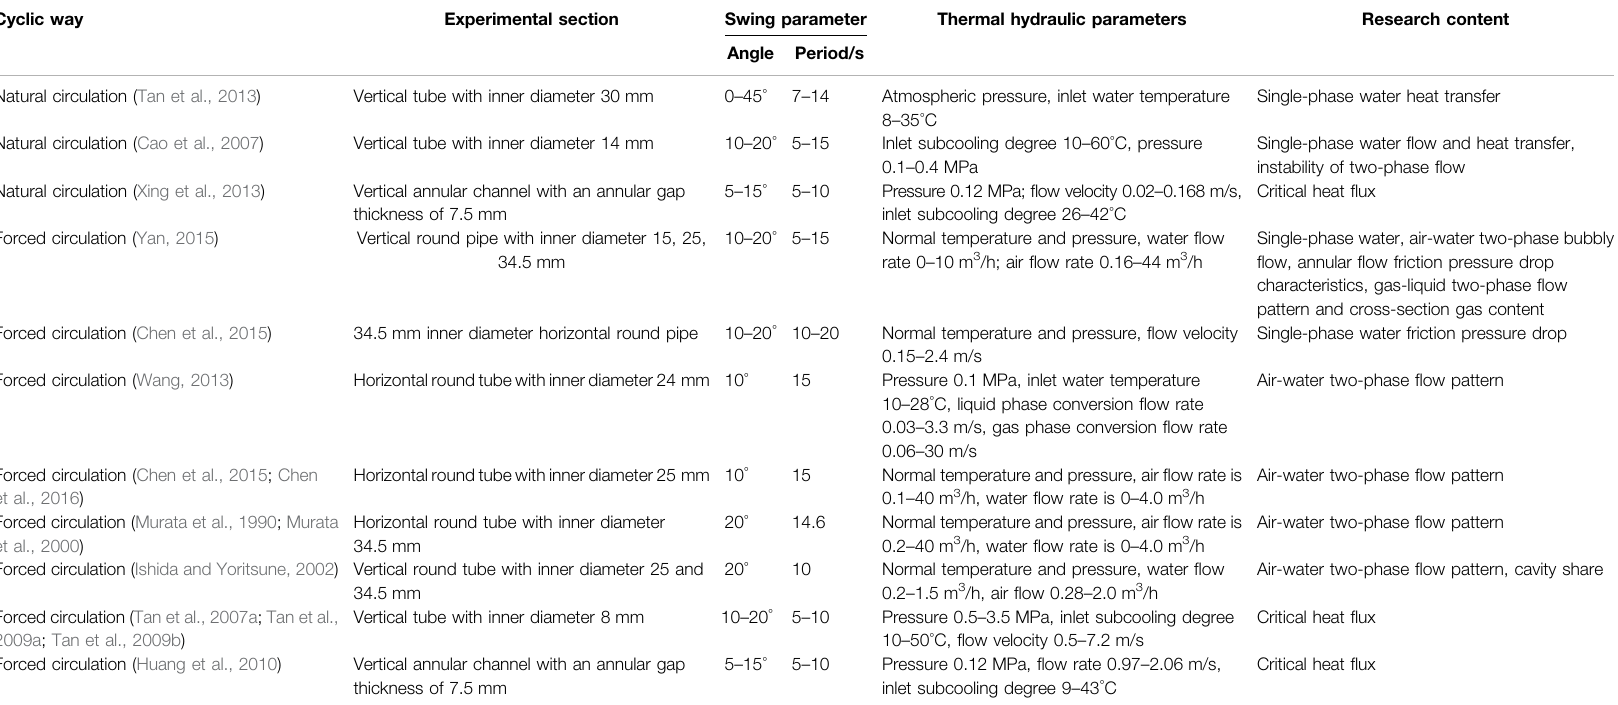
TABLE 2 | Experimental investigations on thermal hydraulics characteristics in-pipe under single dimensional swing in China Cyclic way Experimental section Swing parameter Thermal hydraulic parameters